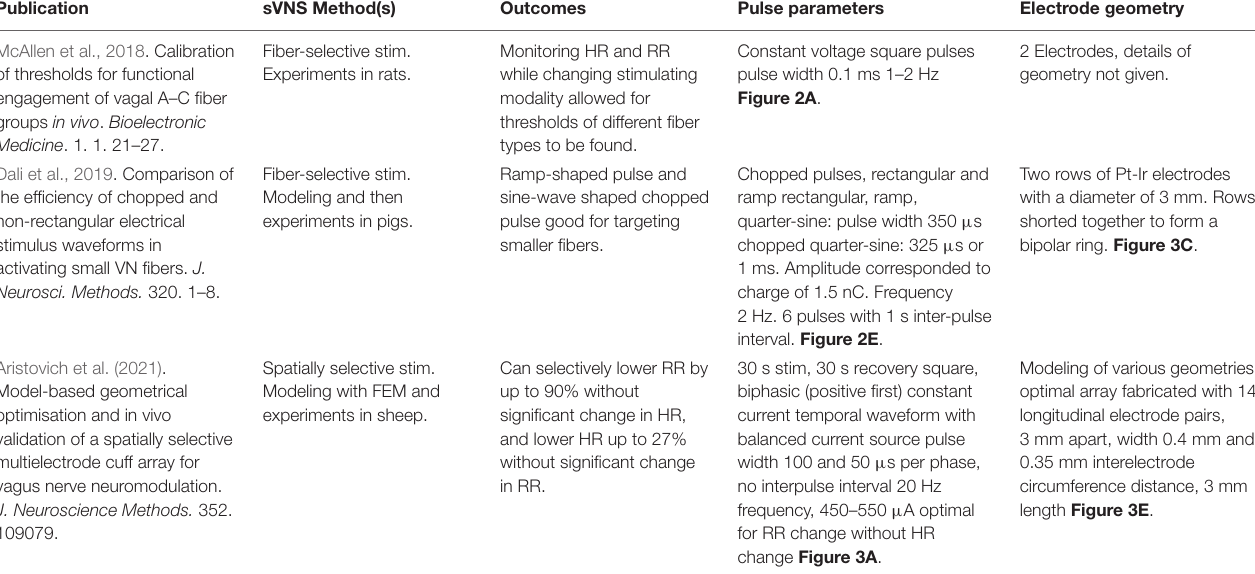
2 Electrodes, details of geometry not given.